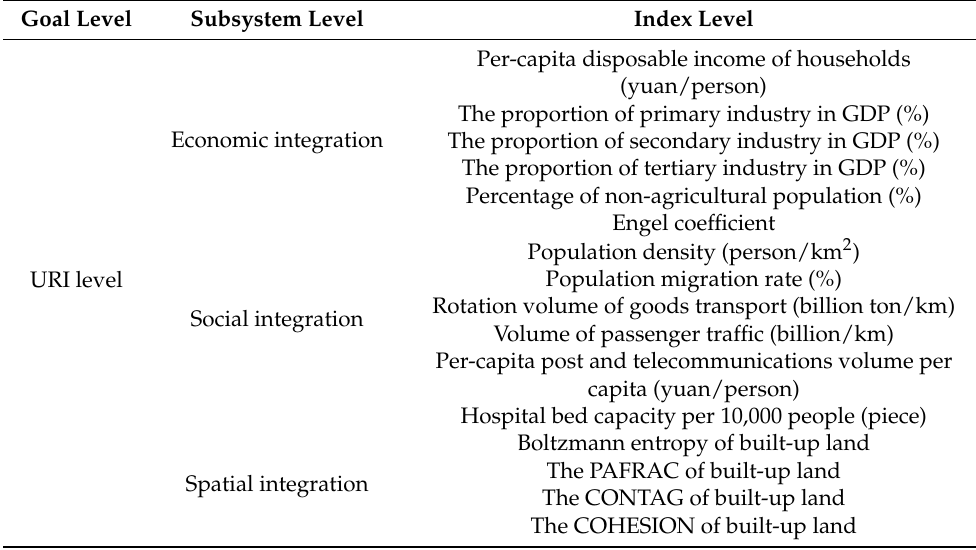
Table 1. The URI indicator